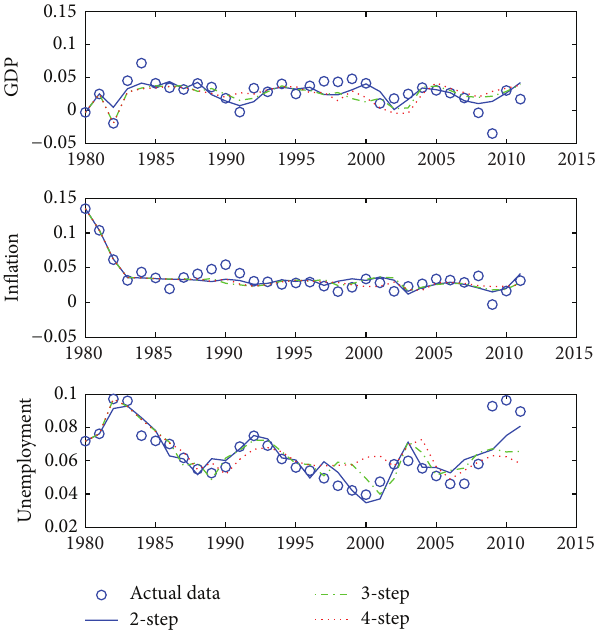
Figure 6: The actual data and in-of-sample prediction of the GDP, inflation, and unemployment with the nonlinear model